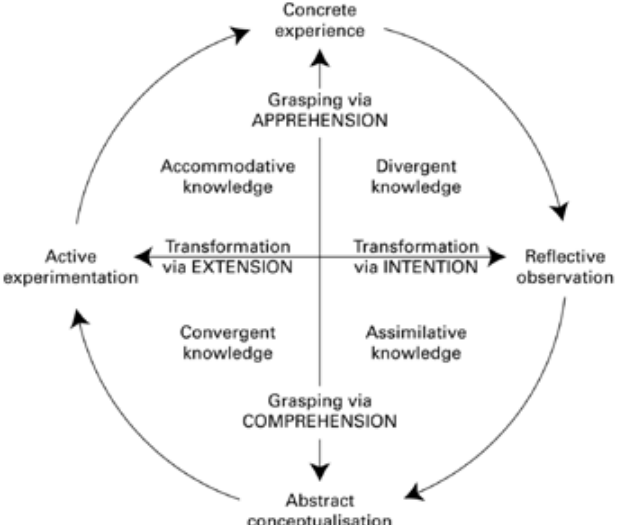
figure 3: Structural dimensions underlying the process of experiential learning and the resulting basic knowledge forms (Kolb, 1984: